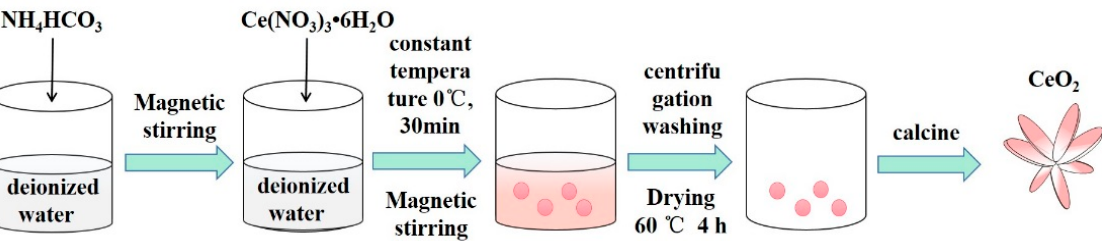
Figure 1. Diagrammatic sketch of the synthesis of CeO 2 nanosheets.